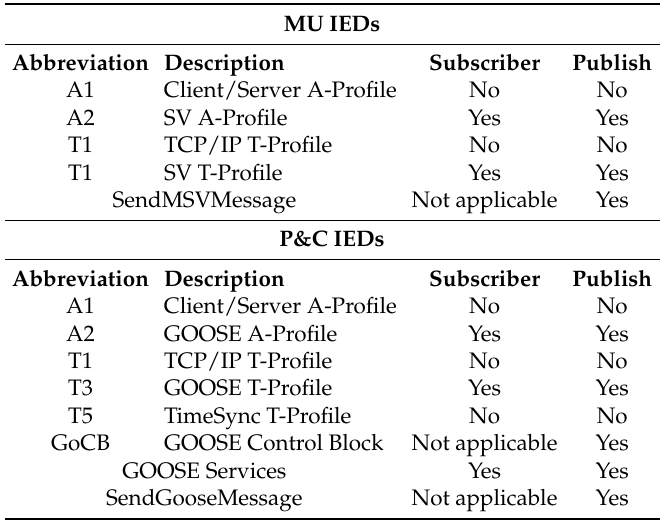
Table A1. Simulator’s A-Profile and T-Profile PICS